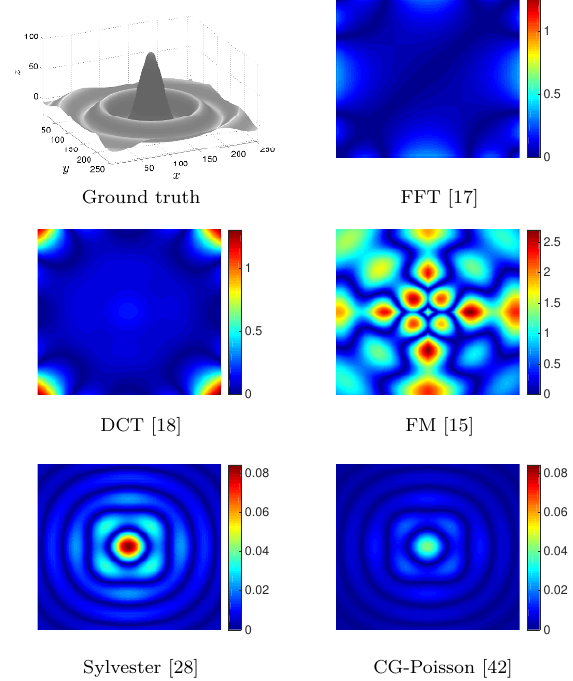
Absolute errors for the “Sombrero” dataset between the ground truth and the numerical result of each method; see Table 2. Note the different scales of the plots. To highlight the differences between all methods we use three different scales. The absolute error map of FM has its own scale due to the fact that the MSE and the maximum error differ compared to the other methods. For FFT and DCT, Sylvester and CG respectively, which have similar values for the MSE and the maximum error, we used the same scale to point out the